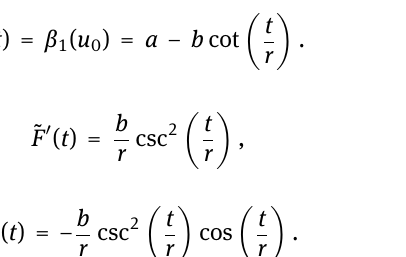
Figure 6: The canonical circle at α ( t ) and the line parameterized by β